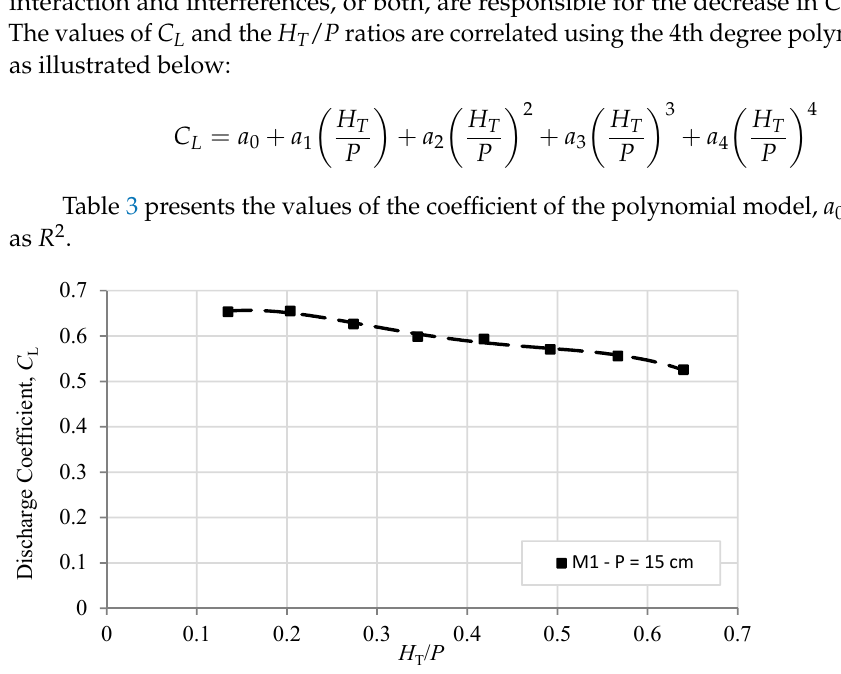
Figure 4. Photographs of the models, h = 70 mm.